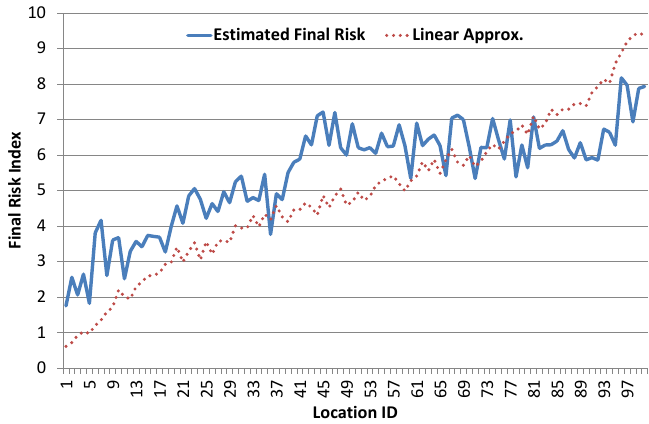
Figure 9. Final risk index results based on linear